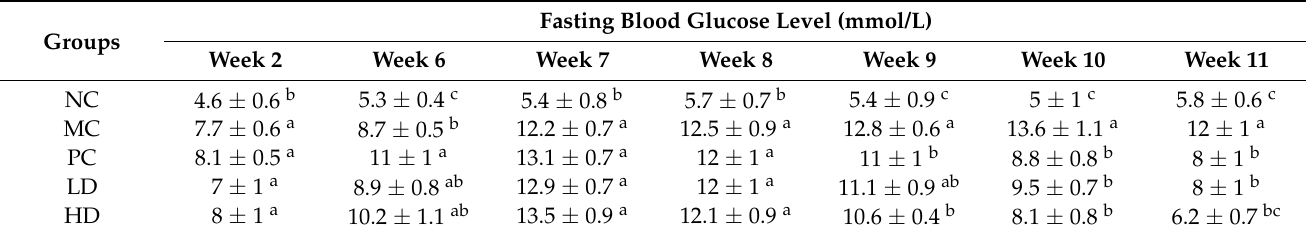
Table 1. Effect of EPS103 on fasting blood glucose levels of T2DM